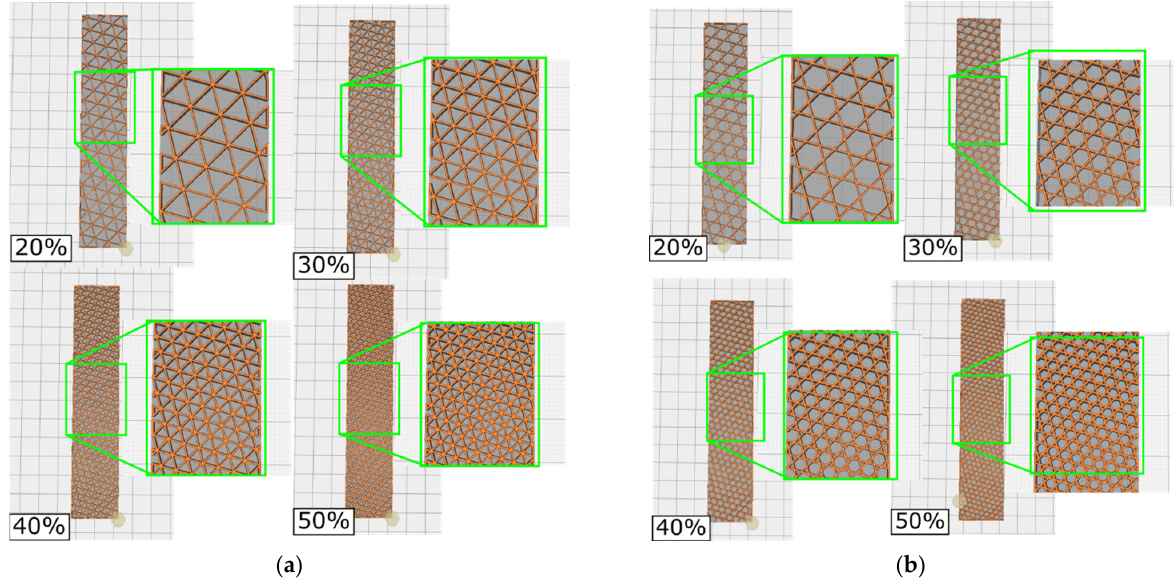
Figure 3. Infill patterns for ( a ) hexagonal and ( b ) star showing the different infill densities.